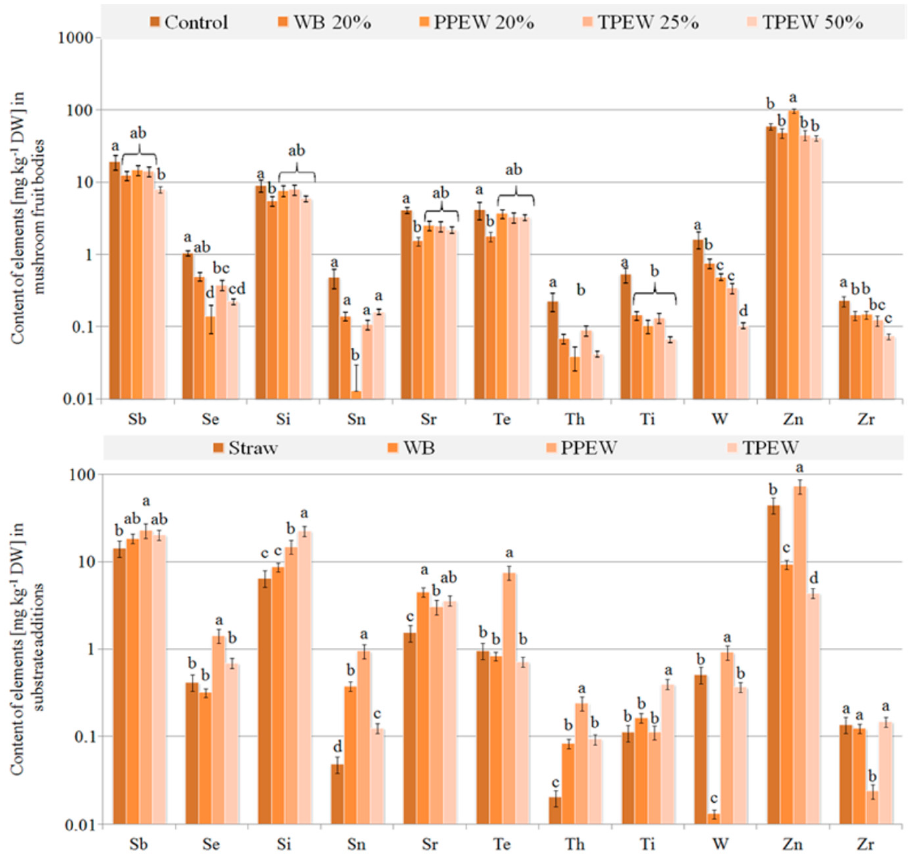
Figure 5. Content of trace elements (mg kg − 1 DM) in Pleurotus citrinopileatus fruit bodies ( a ) and particular additions included to substrate ( b ). Mean values ( n = 3); identical superscripts ( a–d ) denote no significant ( p < 0.05) difference between mean values in columns according to Tukey’s HSD test (ANOVA) for mushrooms growing at particular substrates. WB—wheat bran, PPEW—pumpkin post-extraction waste, TPEW—thymus post-extraction waste. Table 2. Content of aliphatic low-molecular organic acids (LMWOAs) ( µ g g − 1 DM) in fruit bodies of Pleurotus citrinopileatus growing at substrates enriched with different